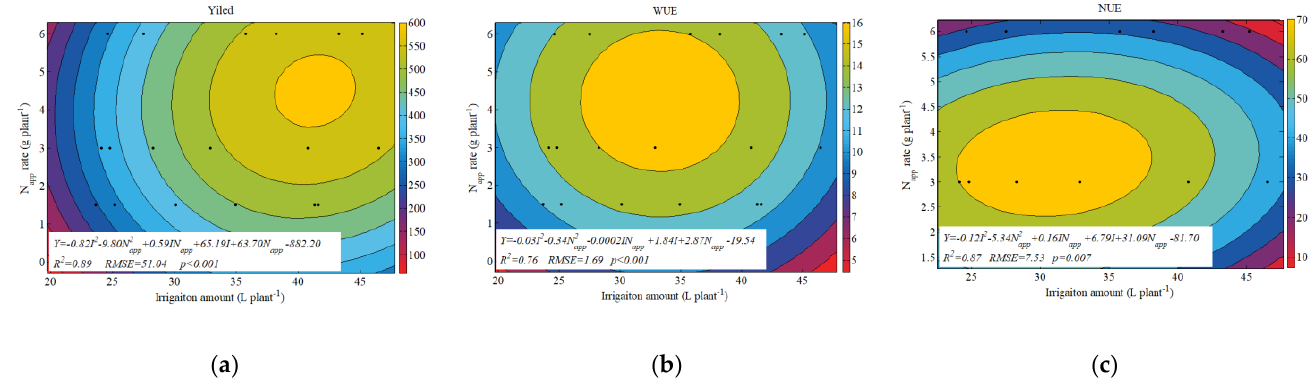
Figure 5. Relationship models of yield, water and nitrogen use efficiency, and irrigation amount and N app rate, respectively; ( a ) was the relationship model between yield, irrigation amount, and N app rate; ( b ) was the relationship model between water use efficiency (g L − 1 ), irrigation amount, and N app rate; ( c ) was the relationship model between nitrogen use efficiency (g g − 1 ), irrigation amount, and N app rate. N app means nitrogen application.